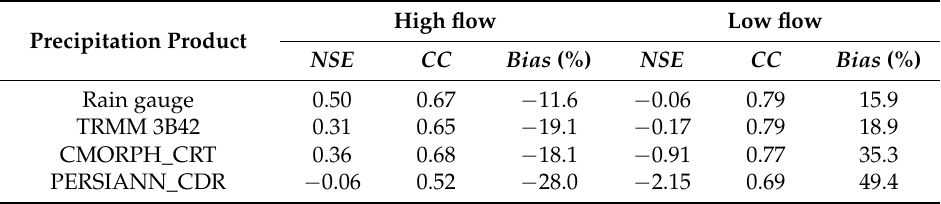
Table 7. Comparison of daily high-flow and low-flow simulations using four precipitation inputs against observations. High flow Low Precipitation Product